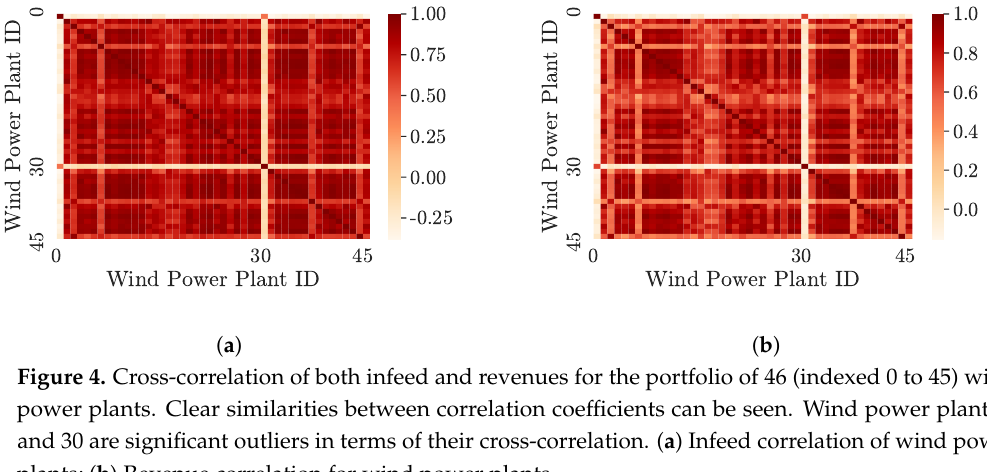
Figure 4. Cross-correlation of both infeed and revenues for the portfolio of 46 (indexed 0 to 45) wind power plants. Clear similarities between correlation coefficients can be seen. Wind power plants 0 and 30 are significant outliers in terms of their cross-correlation. ( a ) Infeed correlation of wind power plants; ( b ) Revenue correlation for wind power plants.